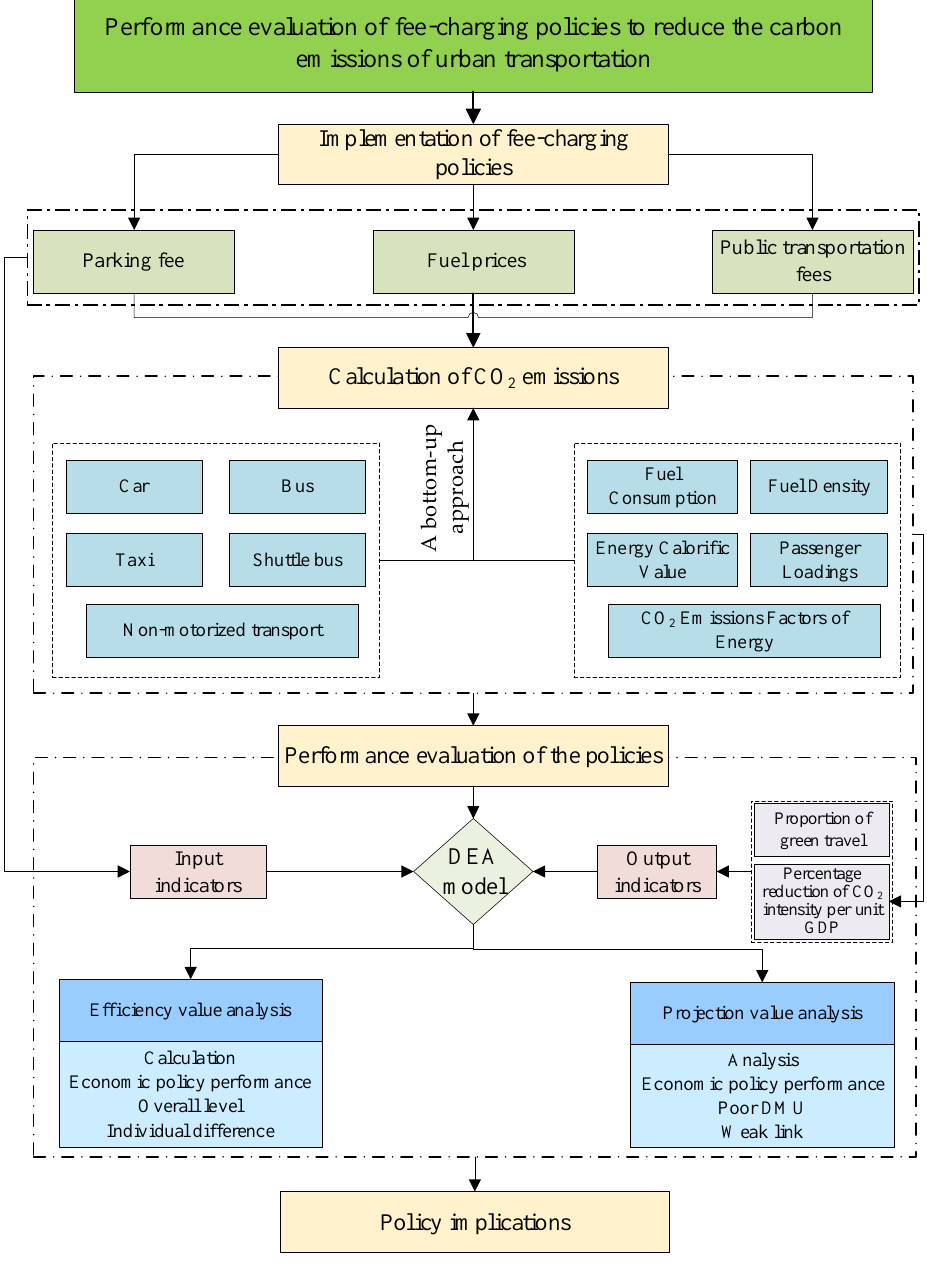
Figure 2. The methodological framework of this study.